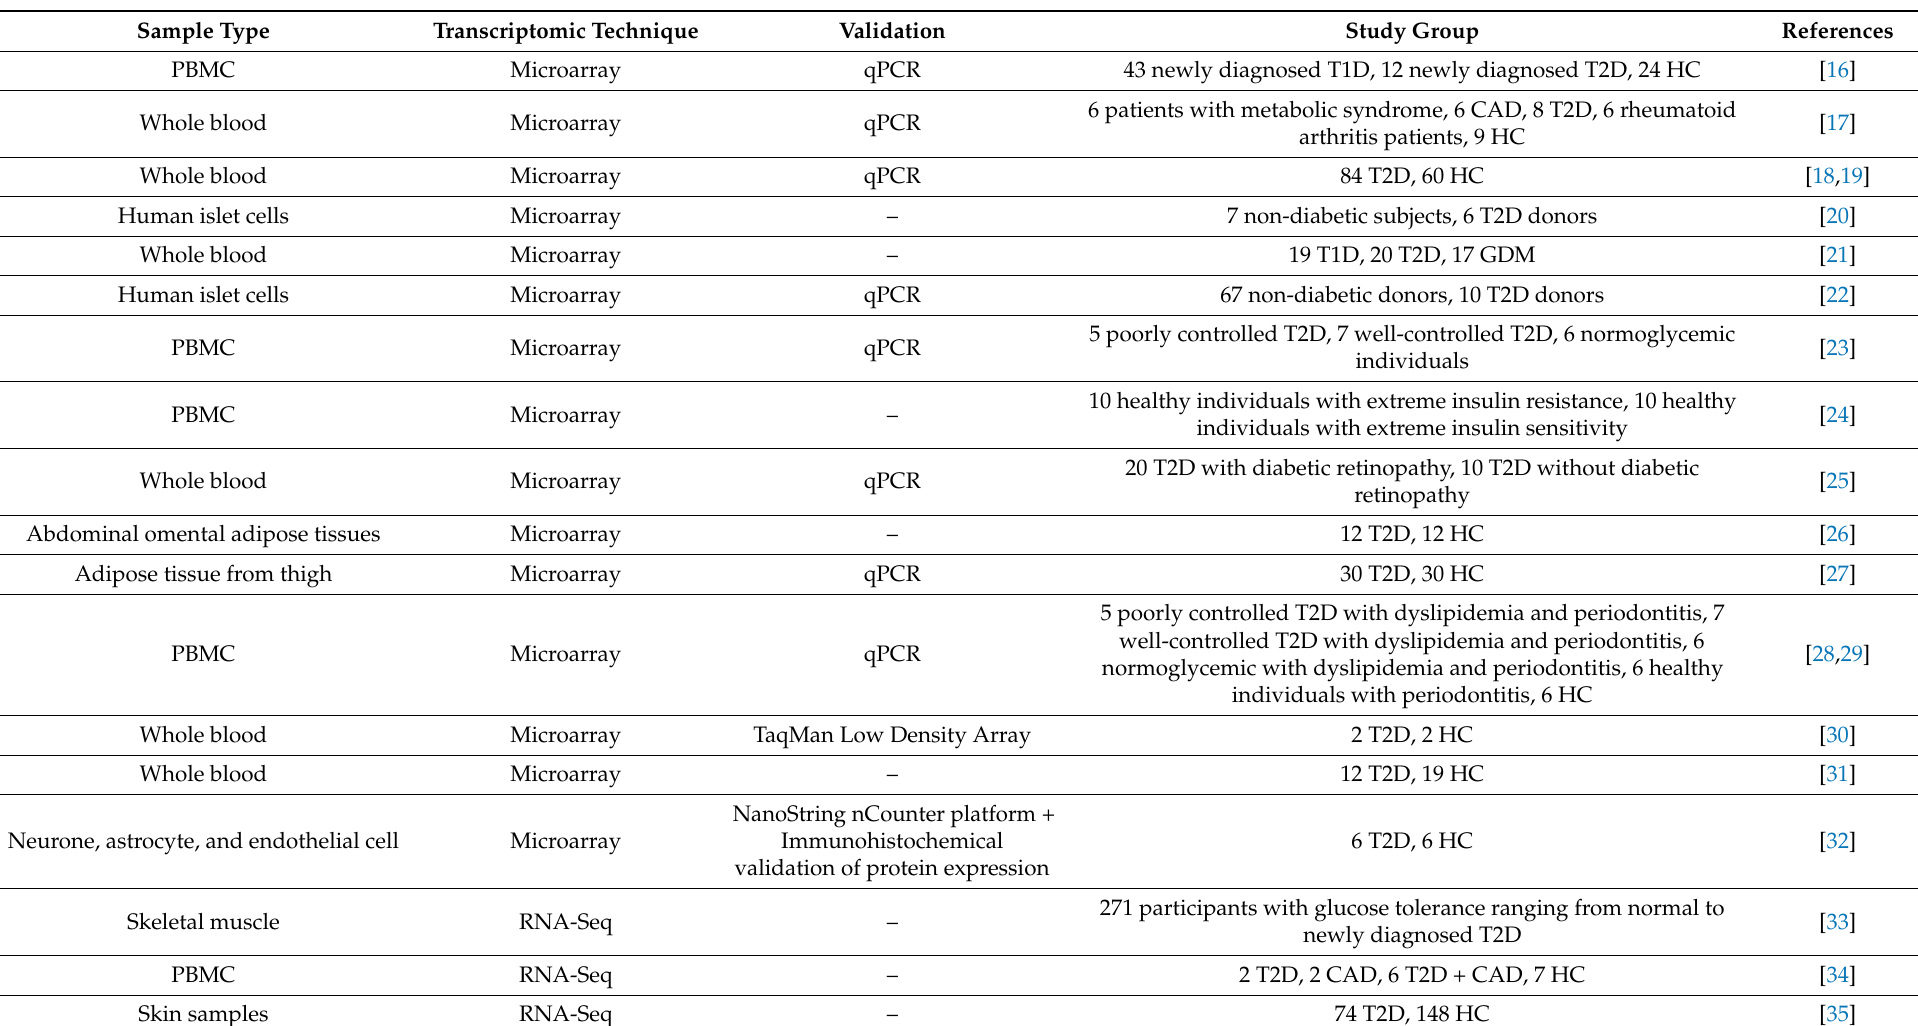
Table 1. Transcriptomic studies in T2D